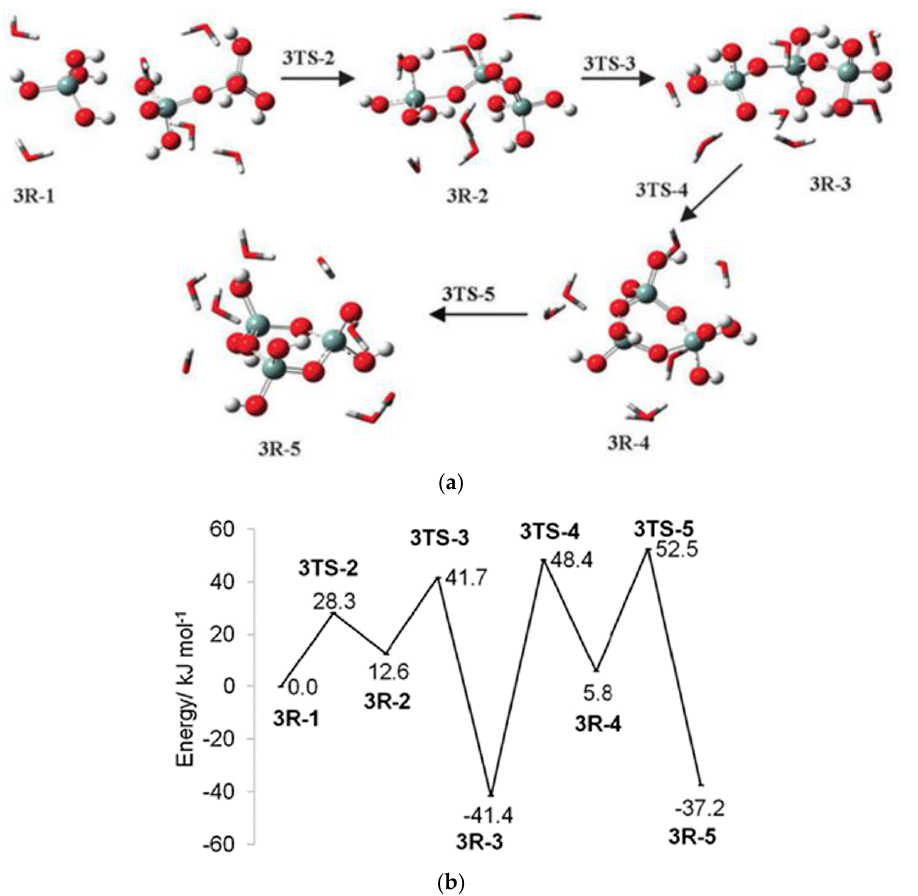
Figure 28. ( a ) Scheme of the H 4 SiO 4 + H 5 Si 2 O 7 − channel for the formation of a trimer, ( b ) the PES for this channel. Reprinted with permission from [17]. Copyright Royal Society of Chemistry, 2013.